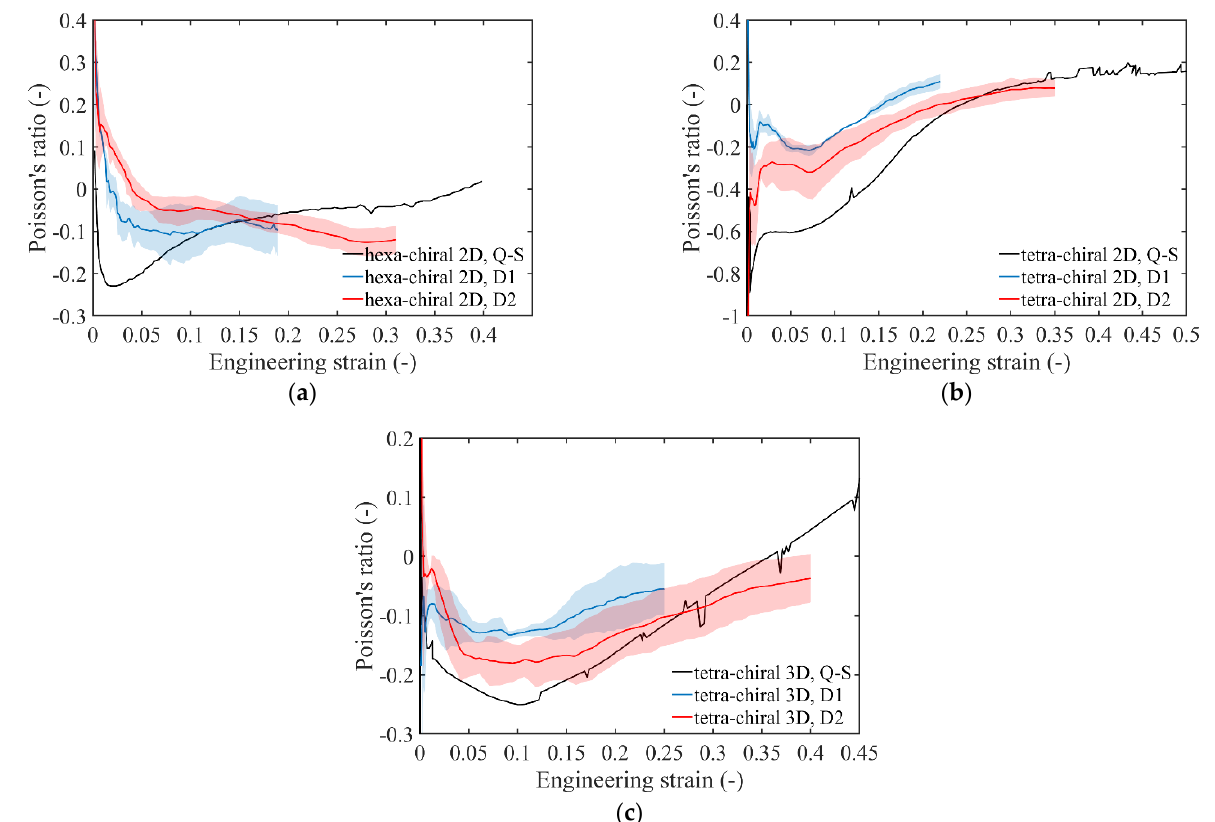
Figure 9. The Poisson’s ratio variation during dynamic testing at impact velocities D1 and D2 for: ( a ) hexa-chiral 2D, ( b ) tetra-chiral 2D, and ( c ) tetra-chiral 3D structure.